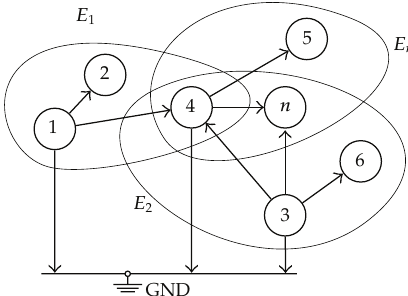
Figure 2: Associated network X resulting from the superposition of m elementary